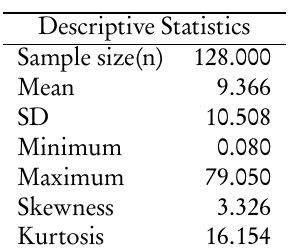
Descriptive statistics of the remission times (in months) of 128 bladder cancer